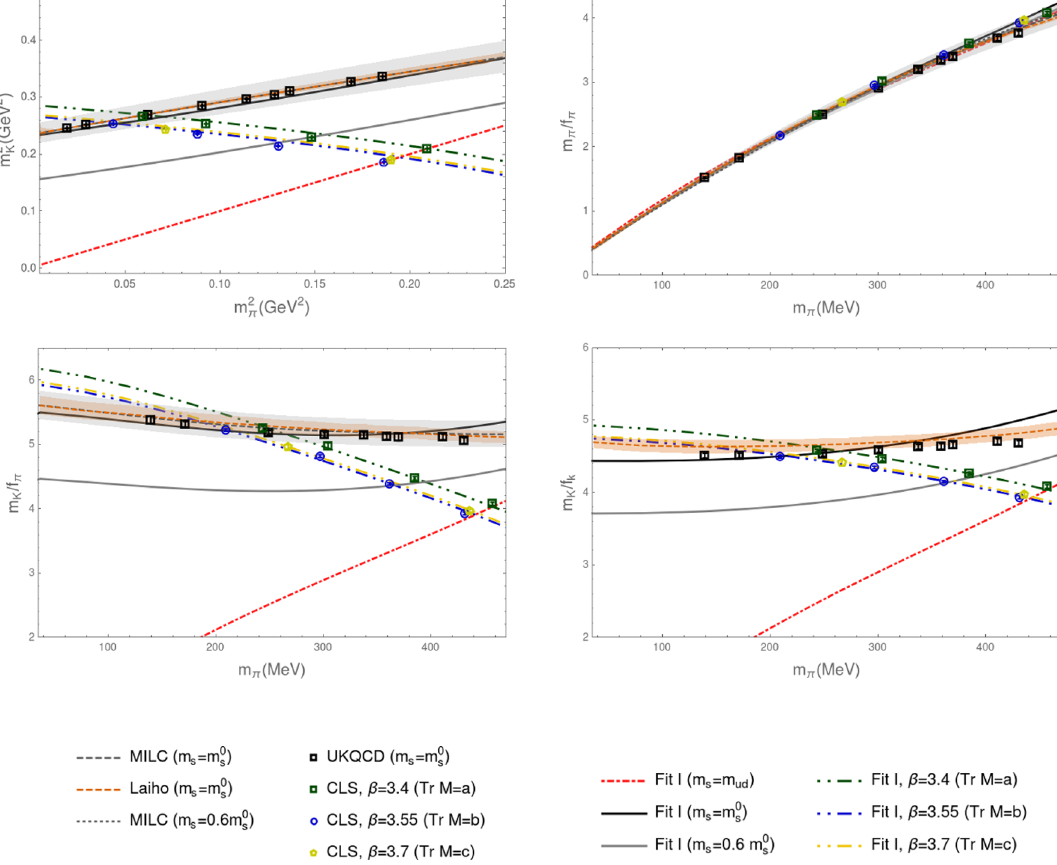
Figure 4 . Chiral trajectories (top-left) and the ratios m (cid:25) =f (cid:25) (top-right), m K =f (cid:25) (bottom-left), and m K =f K (bottom right) obtained in Fit I over the chiral trajectories m s = k and Tr M = C. The light-brown and orange bands correspond to the errors of the MILC and Laiho data, in black and orange dashed lines,